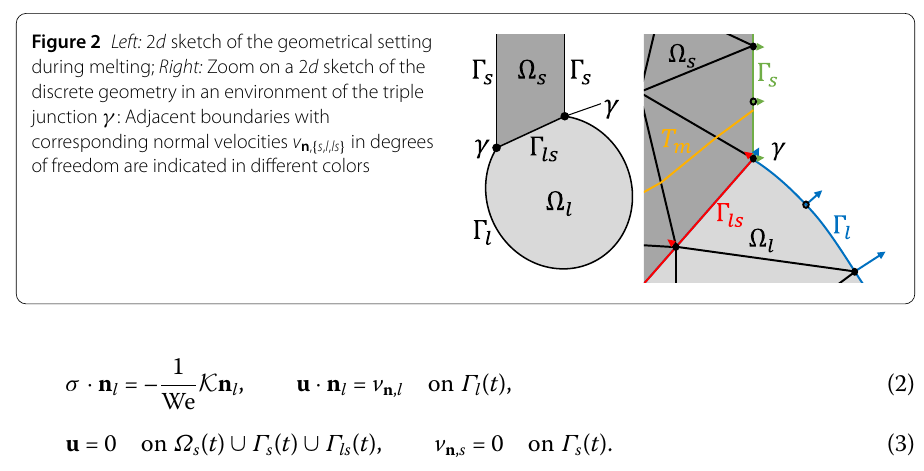
Figure 2 Left: 2 d sketch of the geometrical setting during melting; Right: Zoom on a 2 d sketch of the discrete geometry in an environment of the triple junction γ : Adjacent boundaries with corresponding normal velocities v n , { s , l , ls } in degrees of freedom are indicated in different